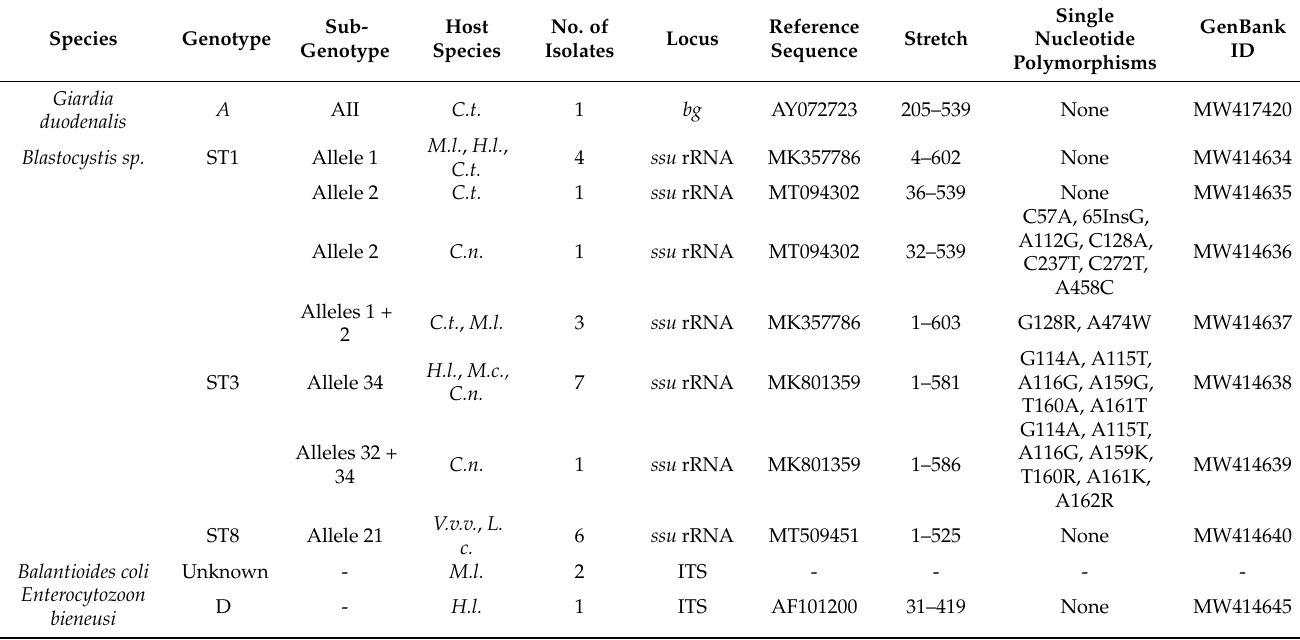
Table 3. Diversity, frequency, and molecular features of Giardia duodenalis , Blastocystis sp., Balantioides coli, and Enterocytozoon bieneusi in faecal samples from captive non-human primates in the C ó rdoba Zoo Conservation Centre (Spain). GenBank accession numbers are